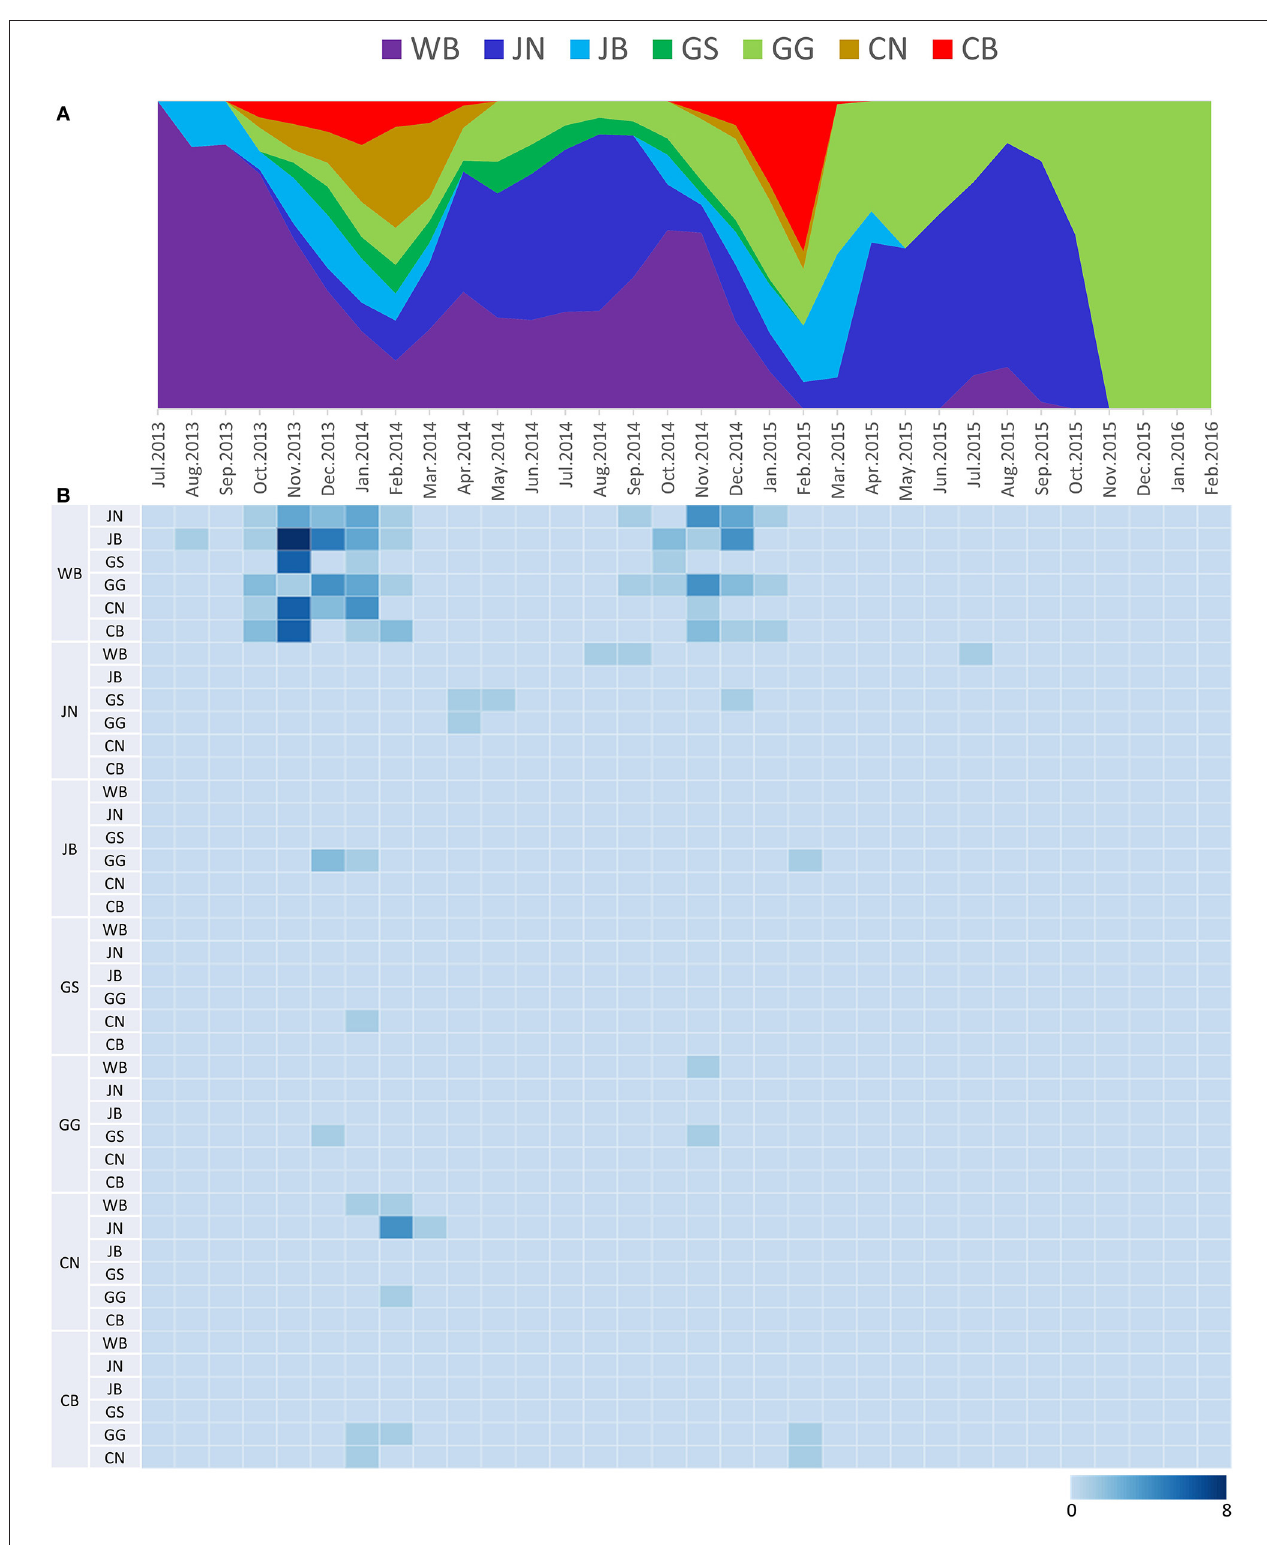
FIGURE 9 | Transition events and discrete state proportion over time of H5N8 high pathogenicity avian influenza viruses isolated in South Korea during 2014–2016. (A) Proportion of ancestral discrete states estimated on the phylogenetic trunk of H5N8 viruses over time. Geographic regions were defined as discrete states. Shaded areas represent estimated ancestral discrete state proportions of each state. At each point in time, the width (y-axis) represents the mean proportion from 0 to 100% of each state. (B) Heat map showing the number of transition events between each discrete state over time (0–8).